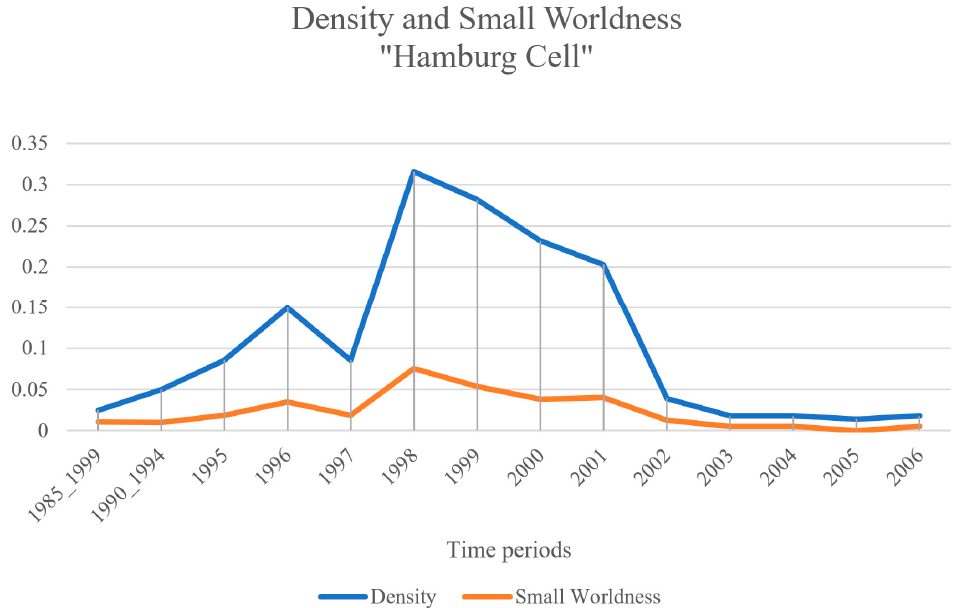
Figure 6. Temporal development of density and small worldness for the “Hamburg Cell”. Both indices increase in 1996, then decrease in 1997, and then increase rapidly again, reaching a maximum in 1998. Afterwards, both indices decrease slowly till 2001, and then decrease rapidly. The observed temporal increase in 1996 is about 45% for small woldrness and about 65% for density, while in 1998 the temporal increase is the same for both (about 250%).